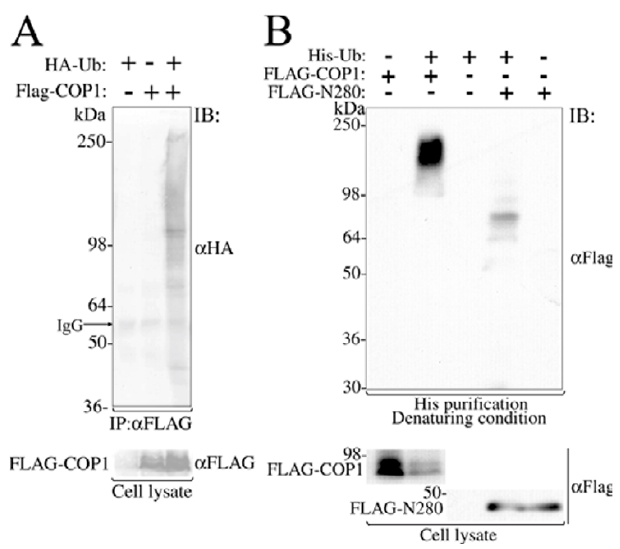
Figure 2 Association of mammalian COP1 with ubiquitin and ubiquitinated protein in vivo. (A) Mammalian COP1 associates to ubiquitinated proteins in vivo. Lysates from 293 cells transfected with FLAG-tagged MmCOP1 and/or HA- tagged ubiquitin were subjected to immunoprecipitation by an anti-FLAG antibody, followed by immunoblotting by anti- HA and anti-FLAG antibodies as indicated. Molecular weights (in kDa) and IgG band are indicated on the left. IP, immuno- precipitation; IB, immunoblot. (B) Mammalian COP1 is a ubiquitination substrate. FLAG-tagged MmCOP1 or N280 and His-tagged ubiquitin were either co-transfected or indi- vidually transfected into 293 cells as indicated. His-tagged ubiquitinated protein was purified from the cell lysates under denaturing condition (in 8 M urea) by using Ni-NTA agarose beads. Immunoblot was performed by using an anti-FLAG antibody as